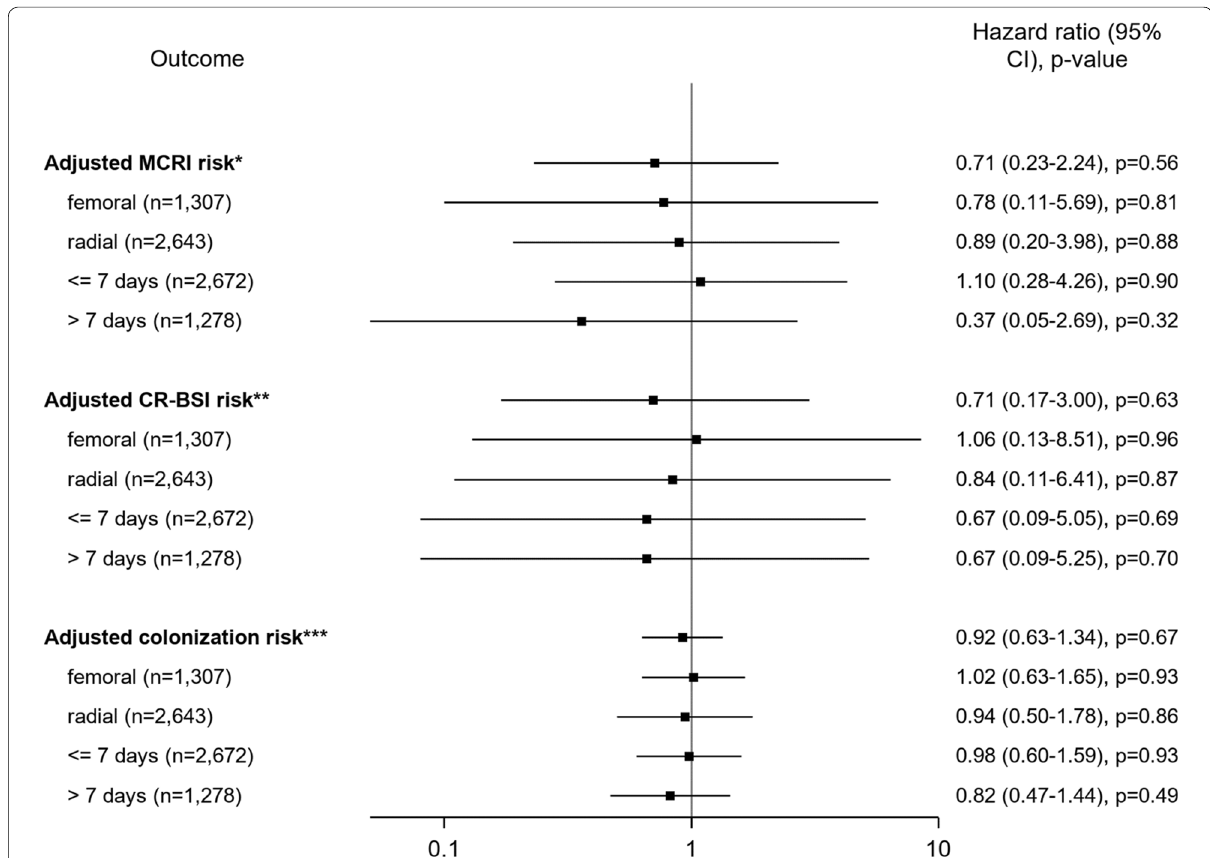
Fig. 2 Adjusted analyses for risk of MCRI, CR‑BSI and colonization for ultrasound guidance versus without ultrasound guidance. *Variables used for adjusting MCRI: SAPS II score, dressing, skin antisepsis, vasopressor at insertion. **Variables used for adjusting CR‑BSI: SAPS II score, skin antisepsis and antibiotic at insertion. ***Variables used for adjusting colonization: vasopressor at admission, SAPS II score, insertion site, dressing, skin antisepsis, mechanical ventilation at insertion, vasopressor at insertion, and antibiotics at insertion. A hazard ratio (HR) less than one indicated a lower risk of event of ultrasound guidance (US) compared with non‑US. CI confidence interval, MCRI Major catheter‑related infection,